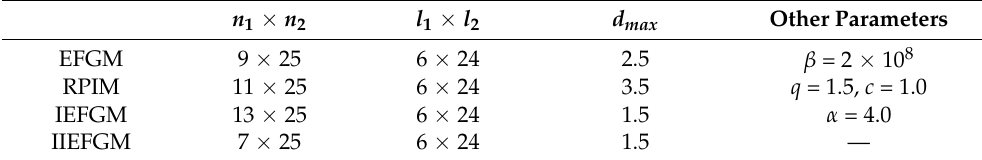
Table 4. Optimal parameters each method within the tested